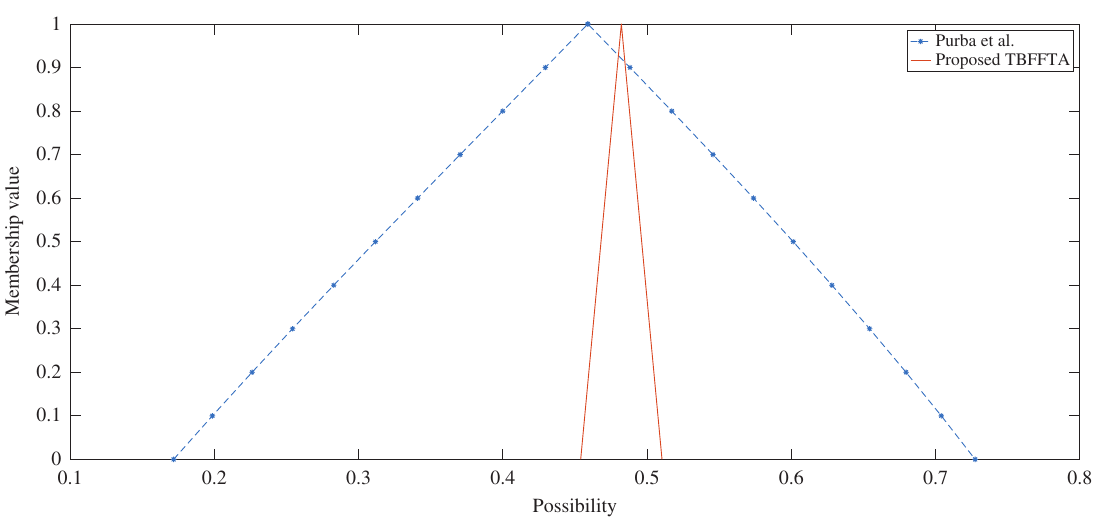
Figure 3: The Best Estimate Fuzzy Possibility of the Top